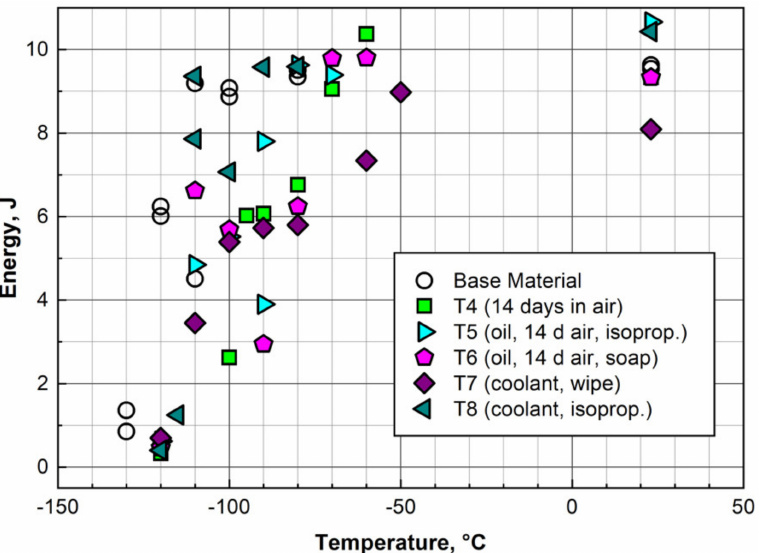
Figure 29. Charpy test results of samples with different cleaning and contamination treatments prior to diffusion bonding at 25 MPa, 1150 ◦ C for 2 h and after post-weld heat treatment of 980 ◦ C/0.5 h + 760 ◦ C/2 h. For comparison, the results with the base material (EUROFER97/2, heat 993402) are plotted by circles. Details of the contamination treatments are given in Table